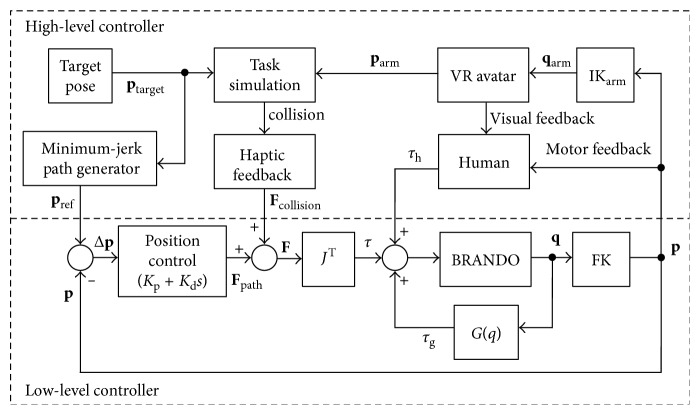
Control architecture for the task simulation through the patient's movements. G(q) is the gravity model to compute the gravity compensation torque; FK is the direct kinematics block; IKarm is the inverse kinematics algorithm of the patient arm. τ and τg are the torque supplied by the motors given the control position and gravity compensation, respectively.